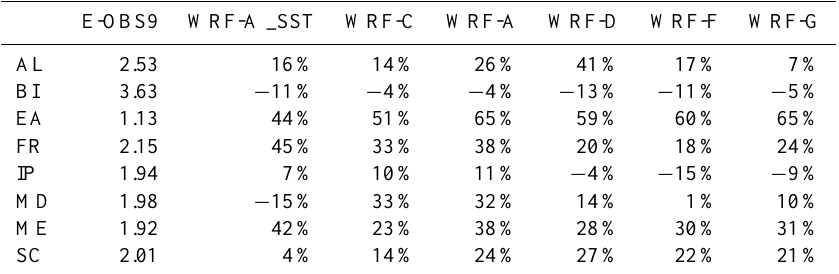
Table 3b. Same as Table 3a for